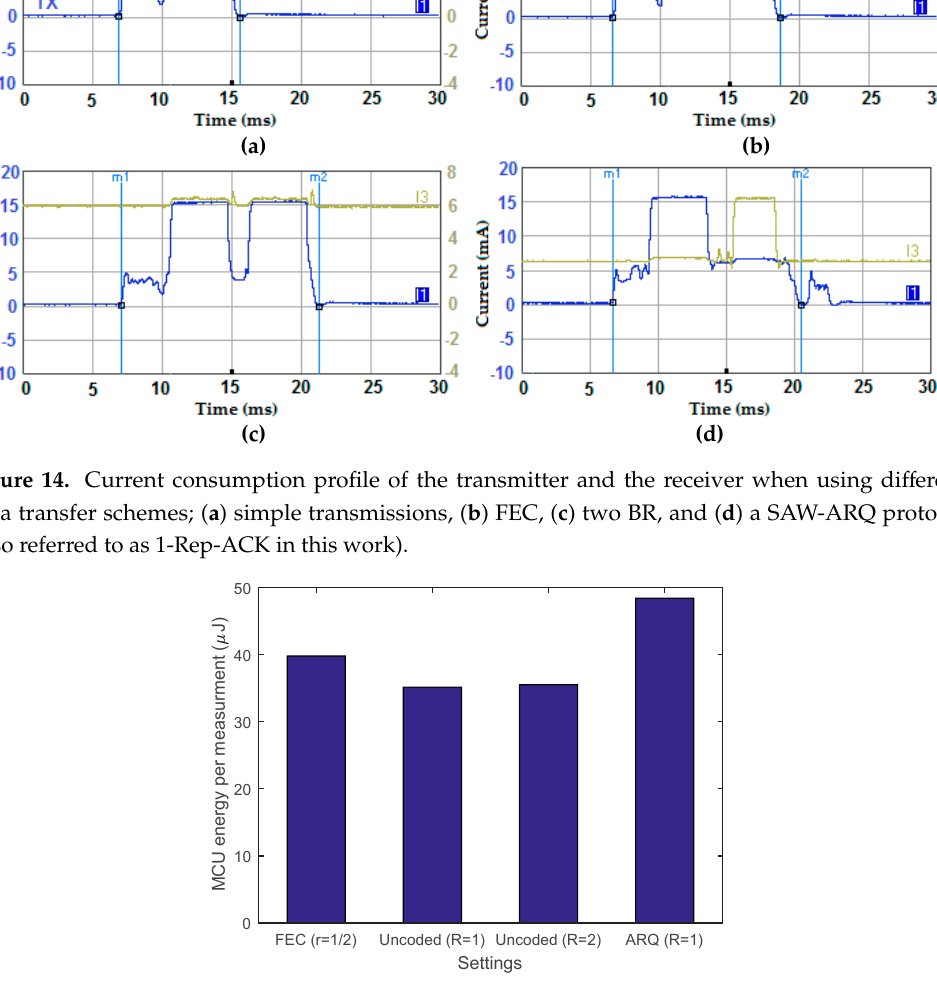
Figure 15. MCU energy consumption per measurement for different data transfer schemes.